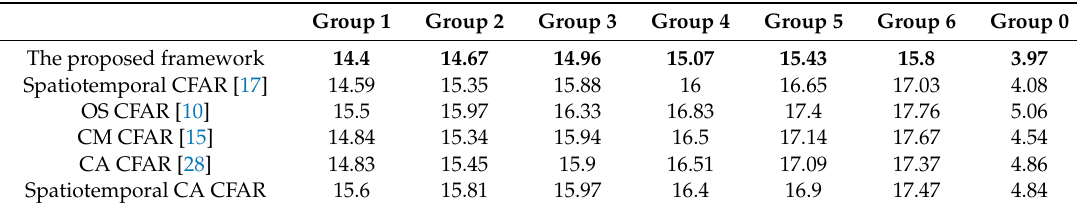
Table 5. OSPA distance of synthetic